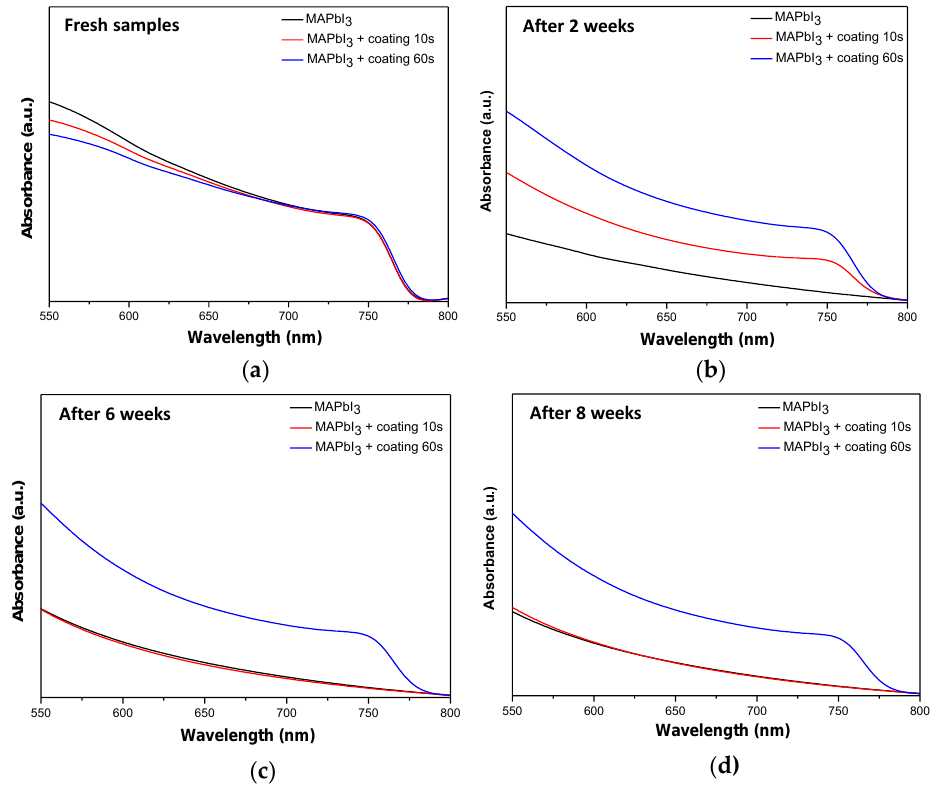
Figure 7. UV-vis absorption spectra of pristine MAPbI 3 film and of samples obtained after the plasma deposition (10 and 60 s) of the fluorocarbon coating on the perovskite after ( a ) 0 week (i.e., fresh), ( b ) 2 weeks, ( c ) 6 weeks and ( d ) 8 weeks of exposure to open air.